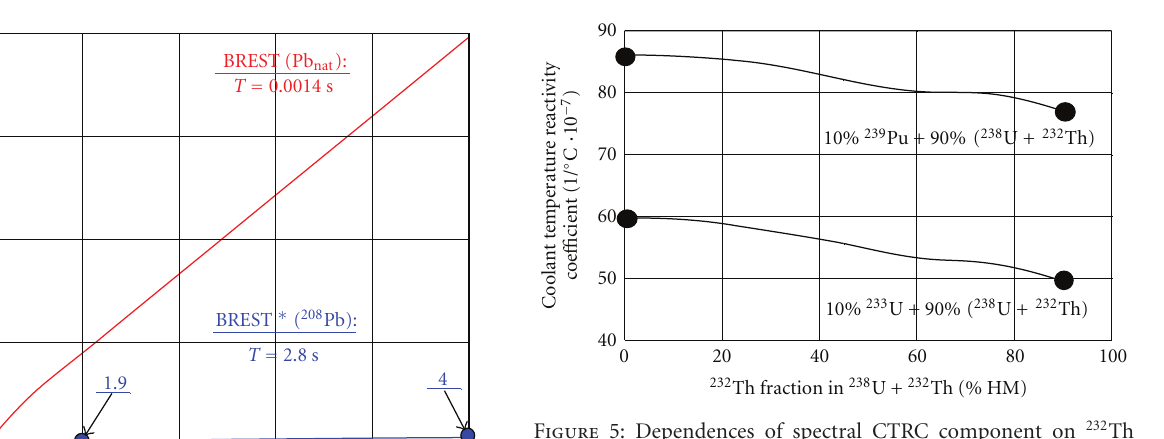
Figure 5: Dependences of spectral CTRC component on 232 Th fraction in fertile component of